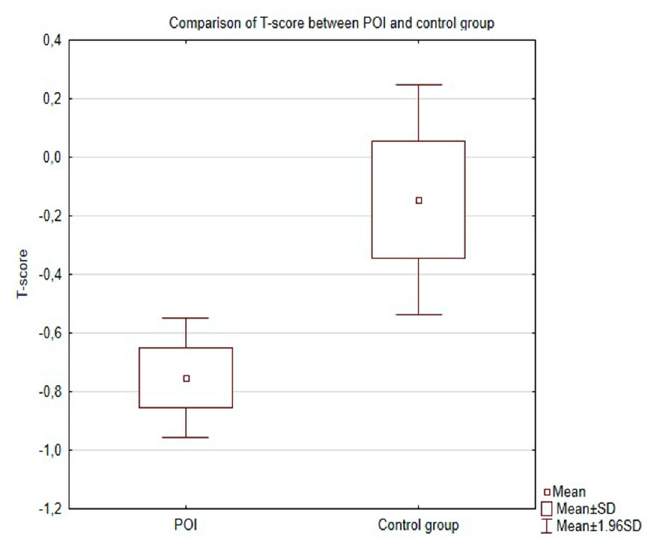
Figure 2. Comparison of T-score between POI and control group.